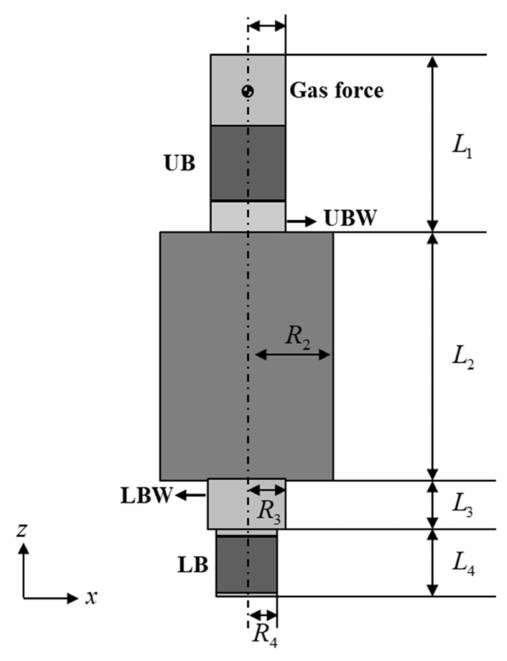
Figure 6. Scroll compressor (SC)